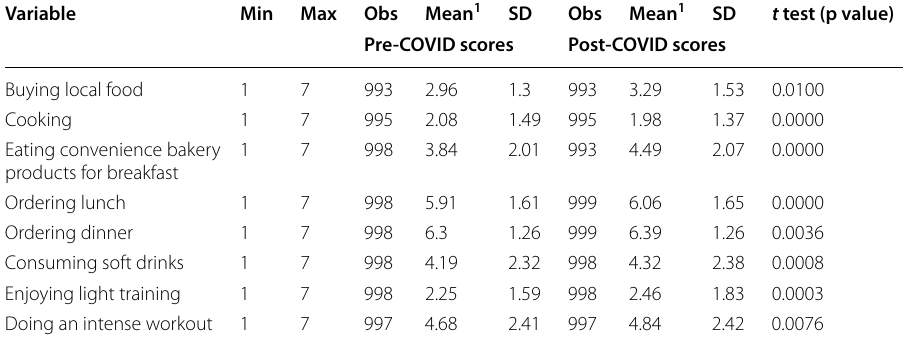
1 Lower values indicate higher frequency